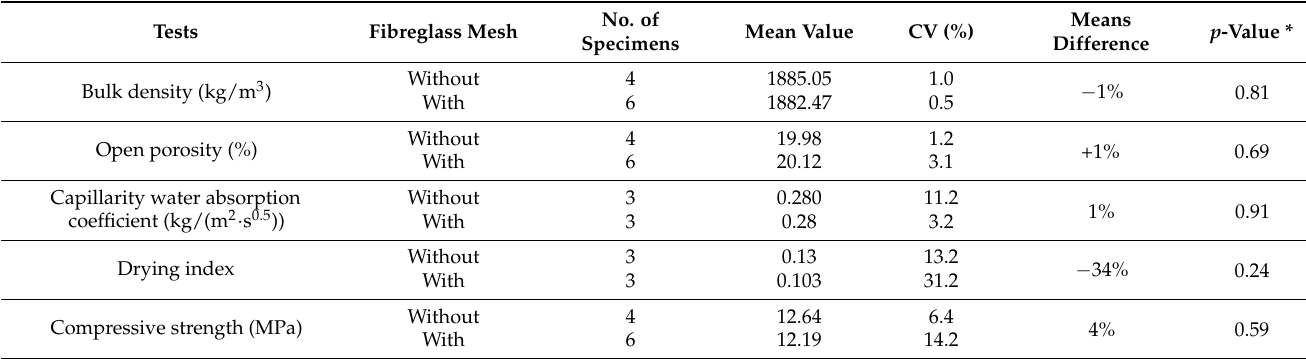
Table 4. Cement mortar applied to the lightweight concrete block